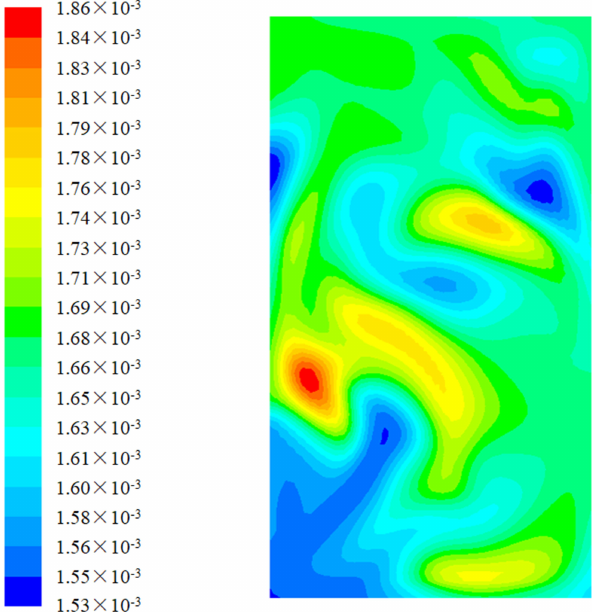
Figure 11. Contours of NH 3 concentration at the observation plane for the optimal design (unit: kg/m 3